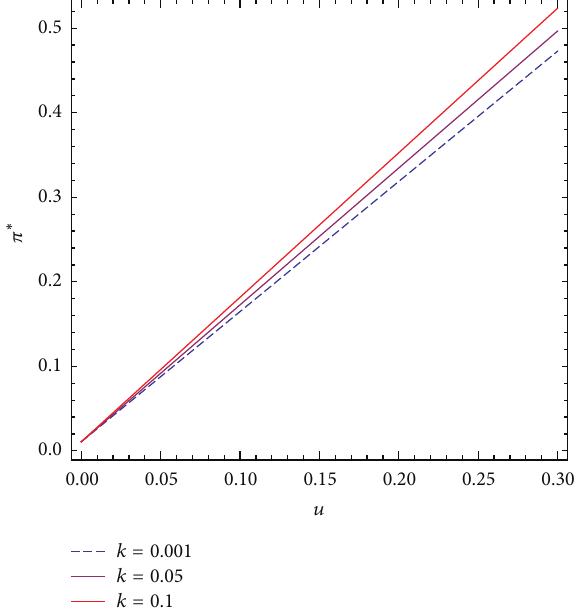
Figure 7: The optimal investment strategy varies with respect to 𝑢 at different 𝑘 .